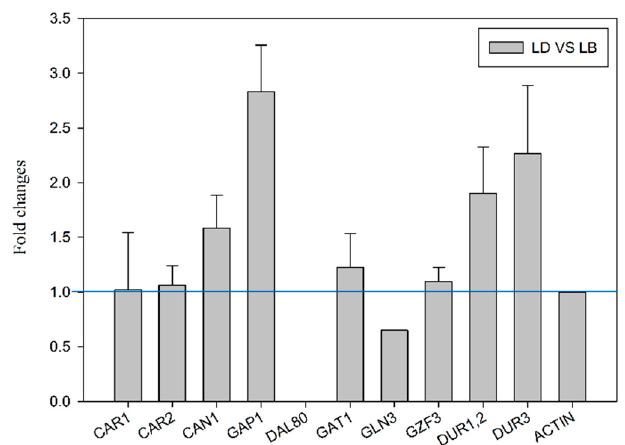
Figure 3. Effect of DAL80 deletion on the transcriptional level of non-preferred nitrogen metabolic genes as well as the NCR regulatory genes. LB: BY4741 under poor nitrogen conditions. LD: dal80 Δ under poor nitrogen conditions.